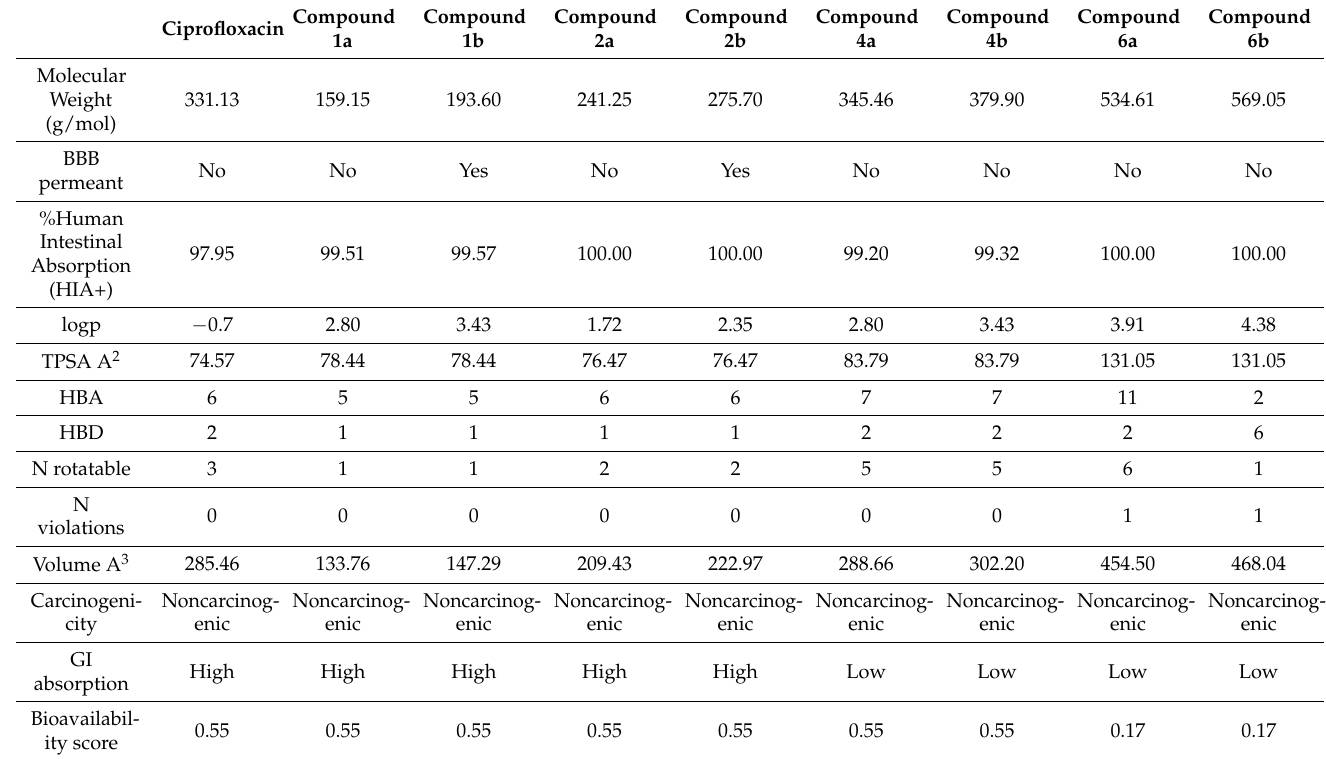
Table 2. ADMET and drug-likeness prediction of newly prepared